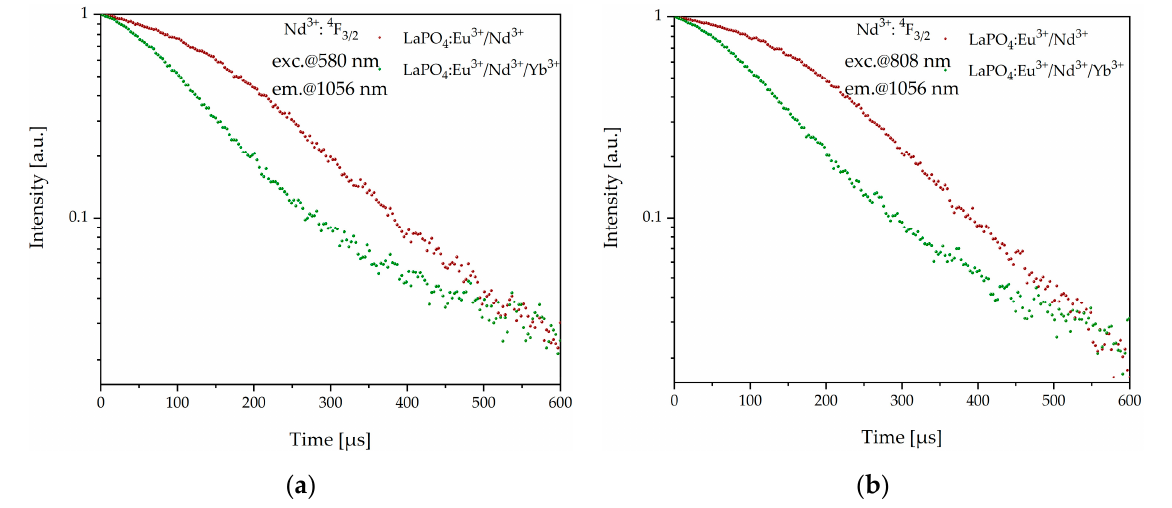
Figure 9. Luminescence decay curves from Nd 3+ : 4 F 3/2 ( a ) excited at 580 nm and ( b ) 808 nm of LaPO 4 :Eu 3+ /Nd 3+ and LaPO 4 :Eu 3+ /Nd 3+ /Yb 3+ samples.